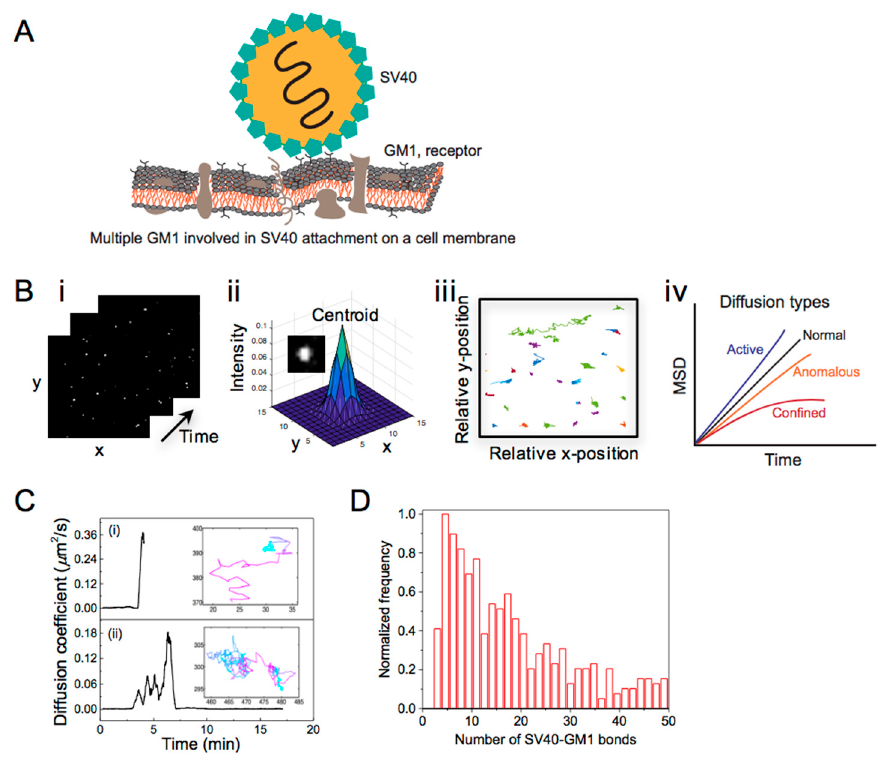
Figure 2. ( A ) Scheme of SV40 attached to the cell membrane via multiple copies of a glycosphingolipid receptor, GM1. The number of SV40-GM1 bonds involve in the virus attachment was determined with single particle tracking (SPT) analysis. ( B ) ( i ) Time-lapse images (25 × 25 μ m 2 ) of single viruses; ( ii ) fitting of the image of a single virus with a 2D Gaussian function; ( iii ) tracks of the detected viruses and ( iv ) mean square displacement (MSD) vs. time plot showing different diffusion types. ( C ) Time-resolved diffusion coefficient evaluated from the SPT analysis displaying transient mobility of SV40 particles during their lateral displacement on a supported phospholipid-bilayer with a few molar percent of GM1. The transient changes in the D of the particle over the track are displayed with the color gradient from cyan (minimum D ) to magenta (maximum D ). ( D ) Histogram of the number of SV40-GM1 bonds involved in the binding of the mobile SV40 on a phospholipid membrane. ©Parveen et al., 2017. Originally published in LANGMUIR. https://pubs.acs.org/doi/pdf/10.1021/acs.langmuir.6b04582 [21].